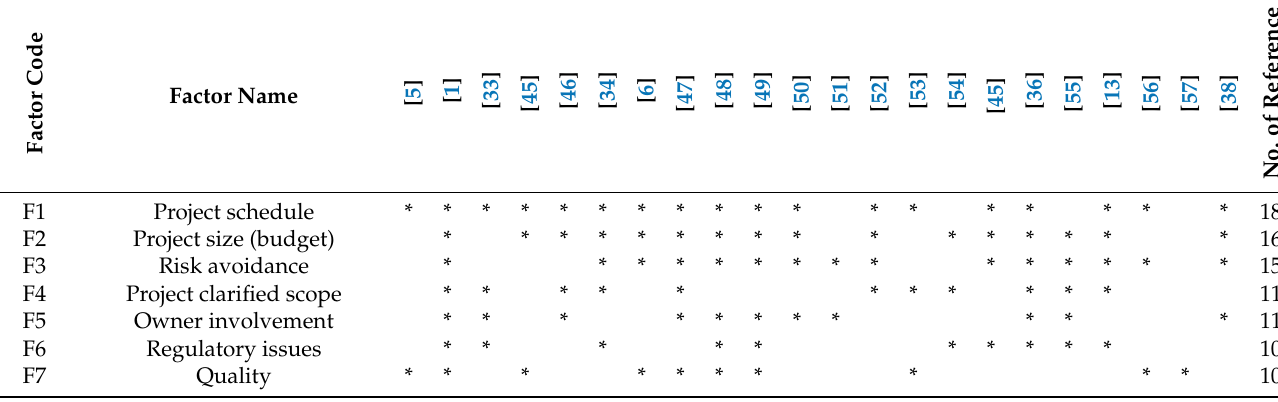
Table 2. Literature of PDS selection factors since